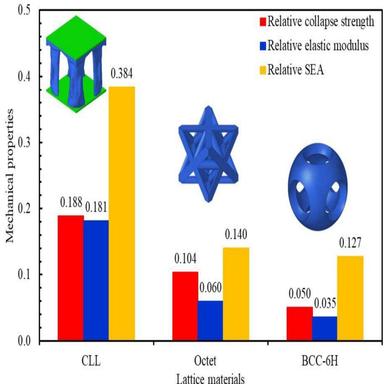
Compressive properties of lattice materials ( ¯ 0.261 = ) with different cell topologies, i.e. CLL, Octet and BCC-6H.